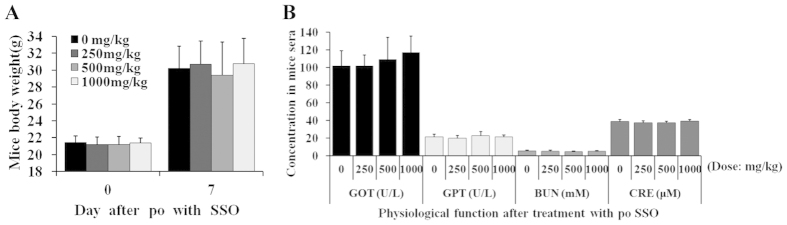
Safety of SSO in mice.Oral administration of SSO (single dosing) in mice (n = 10; ♂ × 5 and ♀ × 5) caused no change in survival and body weight (A); liver and kidney function was without change as well (B). GOT, glutamate-oxaloacetate transaminase (U/L); GPT, glutamate-pyruvate transaminase (U/L); BUN, blood urea nitrogen (mM); CRE, creatine (μM).